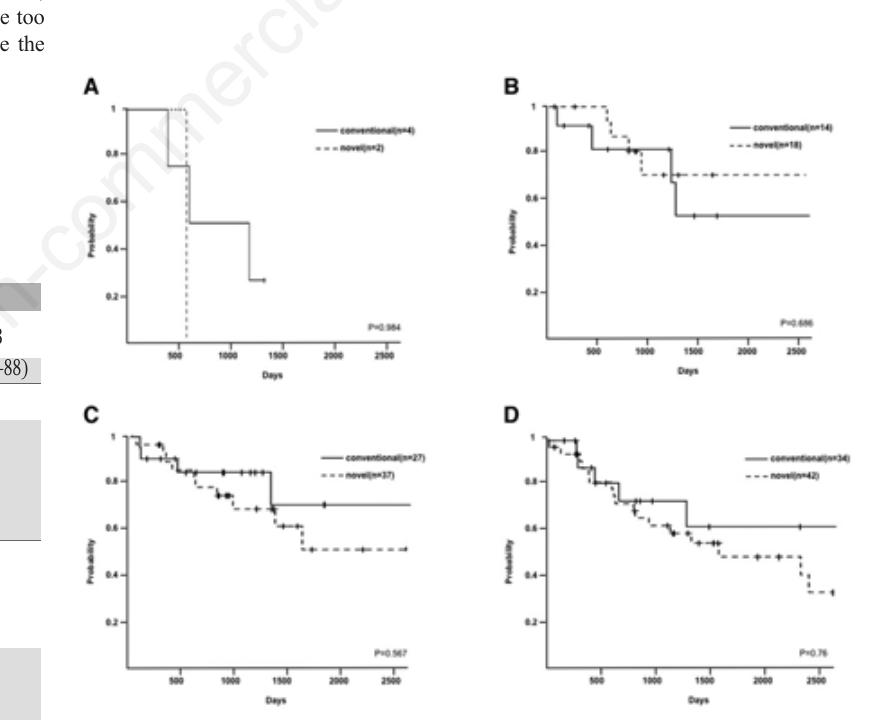
Figure 2. Overall survival according to therapy. A) With hypercalcemia, median overall survival of conventional therapy was 32 months, and with novel agents it was 20 months (P=0.984). B) With renal failure, median overall survival of conventional therapy was 42 months, and with novel agents it was 101 months (P=0.686). C) With anemia, median overall survival of conventional therapy was 105 months, and with novel agents it was 101 months (P=0.567). D) With bone disease, median overall survival of conventional therapy was 96 months, and with novel agents it was 78 months (P=0.76).